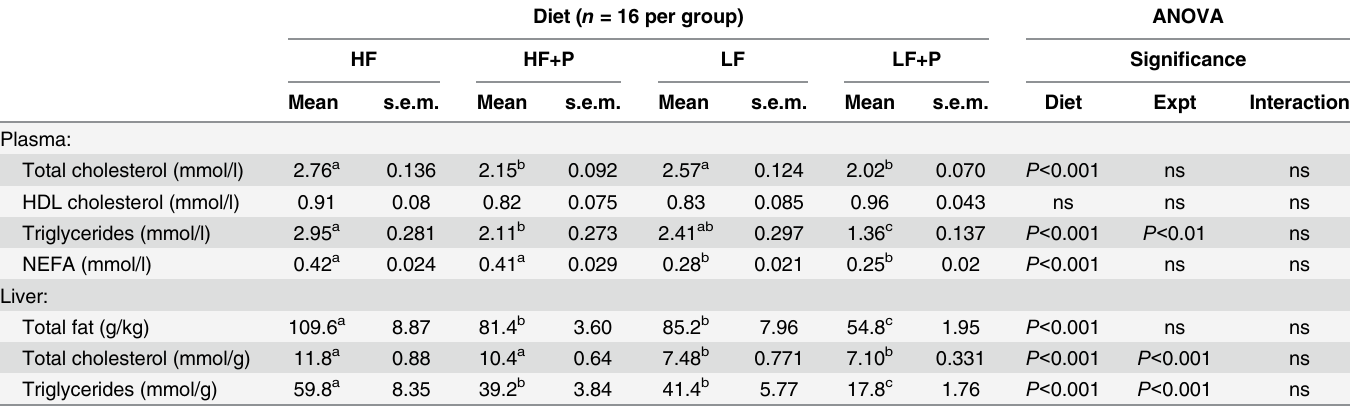
Table 4. Plasma and liver lipid status. Lipid concentrations in plasma and liver of diet-induced obese rats fed high fat diet (HF), high fat diet with 10% w/w pectin (HF+P), low fat diet (LF) or low fat diet with 10% w/w pectin (LF+P) for 4 weeks in two independently replicated experiments. Within rows, means with different superscript letters are significantly different (by Tukey ’ s post hoc